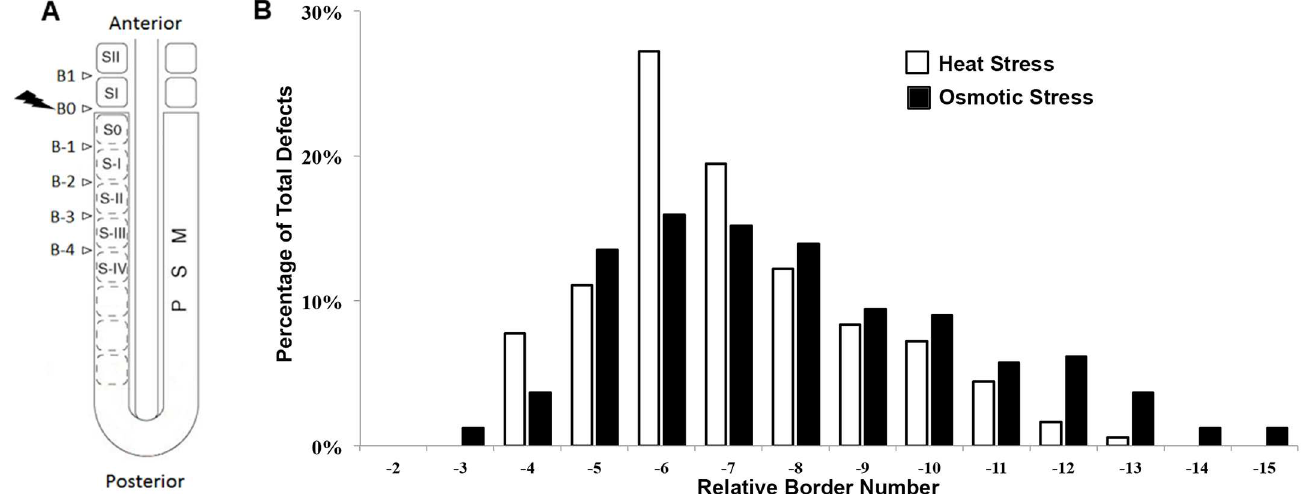
Fig 3. Osmotic and heat shock result in defects centered in the same area. (A) Visualization of somitogenesis to illustrate formed and developing somites and relative border numbers. Lightningbolt indicates where shock begins.(B) Proportionof defects in hyperosmolar shocked (black) and heat shocked (white) embryos, shown relative to the stage at which the osmotic or heat treatment began.